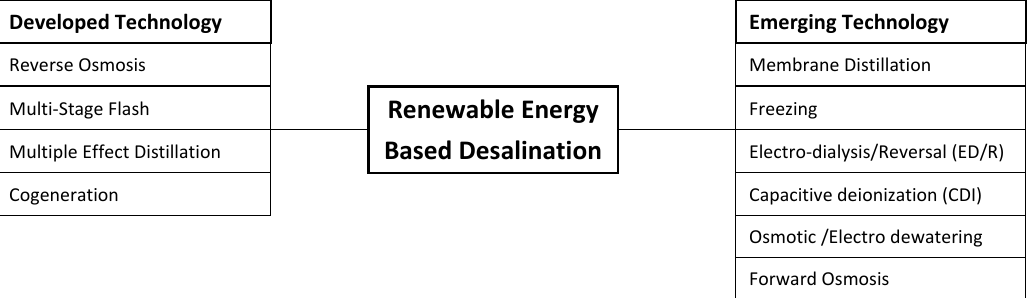
Figure 7. Classification of Solar-based Desalination systems (adapted from [5]).